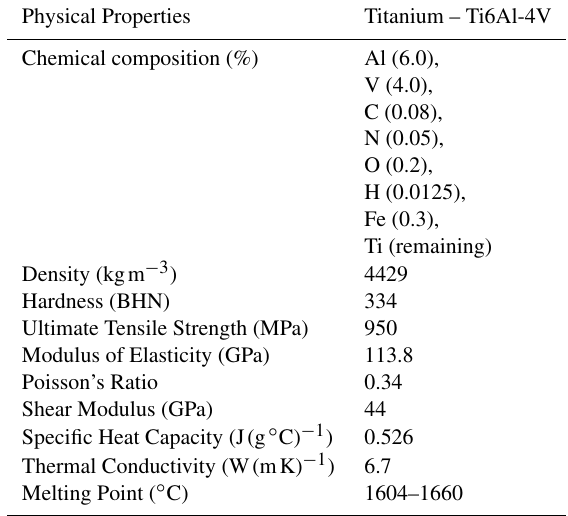
Table 1. Applications, mechanical and physical properties of metal